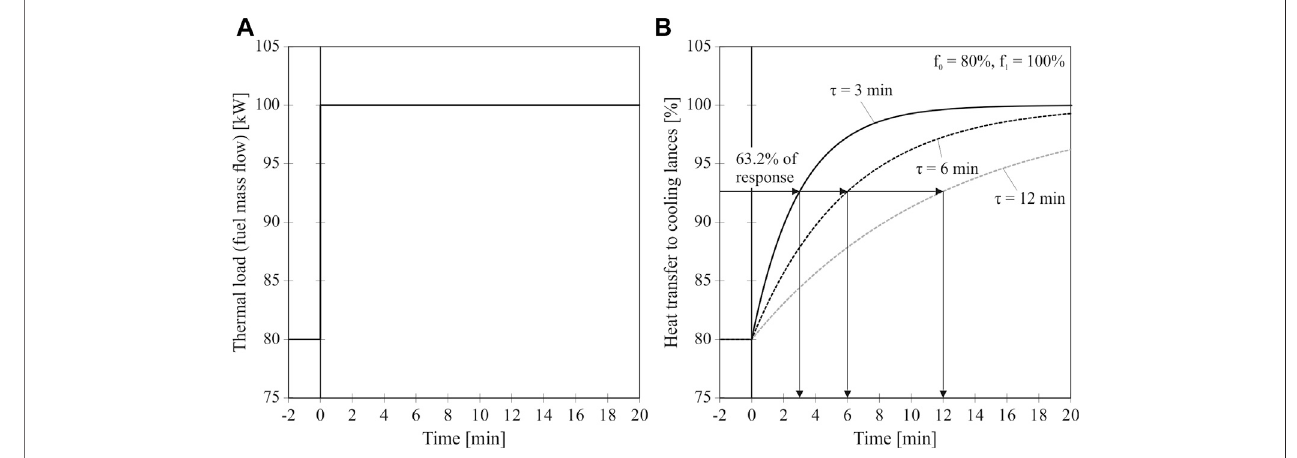
FIGURE 4 | Step input and step response of a fi rst order system with exponential decay. (A) Step input (B) Step response.